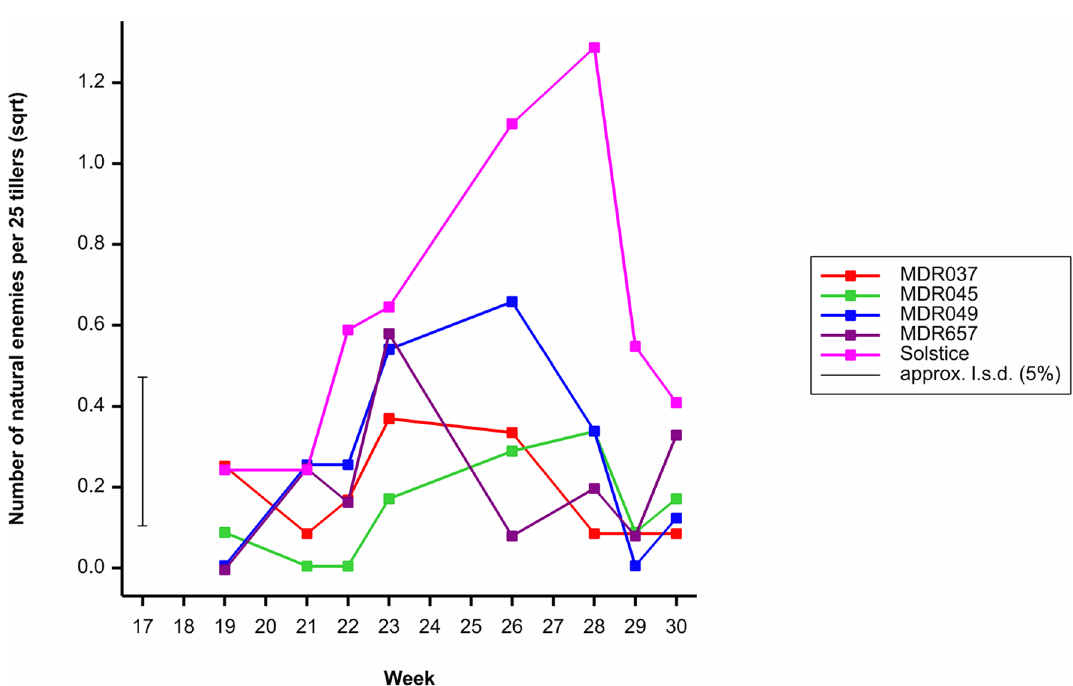
Figure 5. Average number of natural enemies (parasitised mummified aphids, ladybird adults and larvae, and Lacewing eggs and larvae) per 25 tillers observed on Triticum aestivum Solstice, Triticum moncoccum MDR037, MDR657, MDR045 and MDR049 from week 18 to week 30. All data was subject to square root